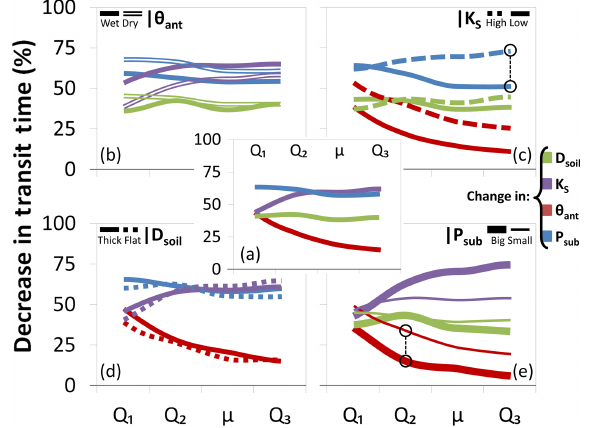
Figure 6. Influence of different properties on different parts of the TTD. Shown is the average percentage decrease in transit time for each quartile ( Q 1 , Q 2 , Q 3 ) and the mean ( µ ) of the TTD caused by a decrease in D soil from 1 to 0.5m (green), an increase in K S from 0.02 to 2md − 1 (purple), an increase in θ ant from 50% to 90% effective saturation S eff (red) and an increase in P sub from 0.3 to 1.4ma − 1 (blue). Panel (a) shows the average decrease in transit time for changing each of the four properties, and panels (b–e) show the decrease in transit time conditional on the variation of one of the four properties ( θ ant , K S , D soil and P sub ). Two examples are illustrated by the black circles: (1) The dashed blue line in (c) shows that the increase in P sub has a larger influence on the third quartile transit time ( Q 3 ) – a decrease of ∼ 75% instead of just ∼ 50% – for a catchment with a high K S compared to a catchment with a low K S . (2) The thick red line in (e) shows that the increase in θ ant from 50% to 90% S eff has a smaller influence on the second quartile transit time ( Q 2 ) – a decrease of just ∼ 15% instead of ∼ 35% – for a catchment with a big P sub compared to a catchment with a small P sub